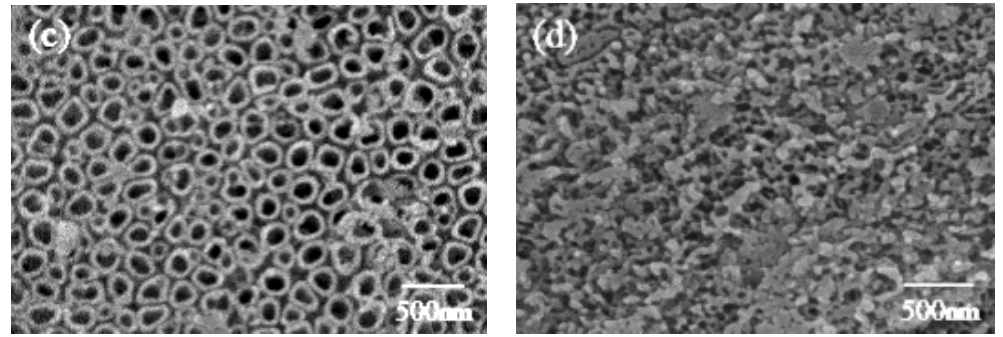
double layer coating; (b) HA/TiO 2